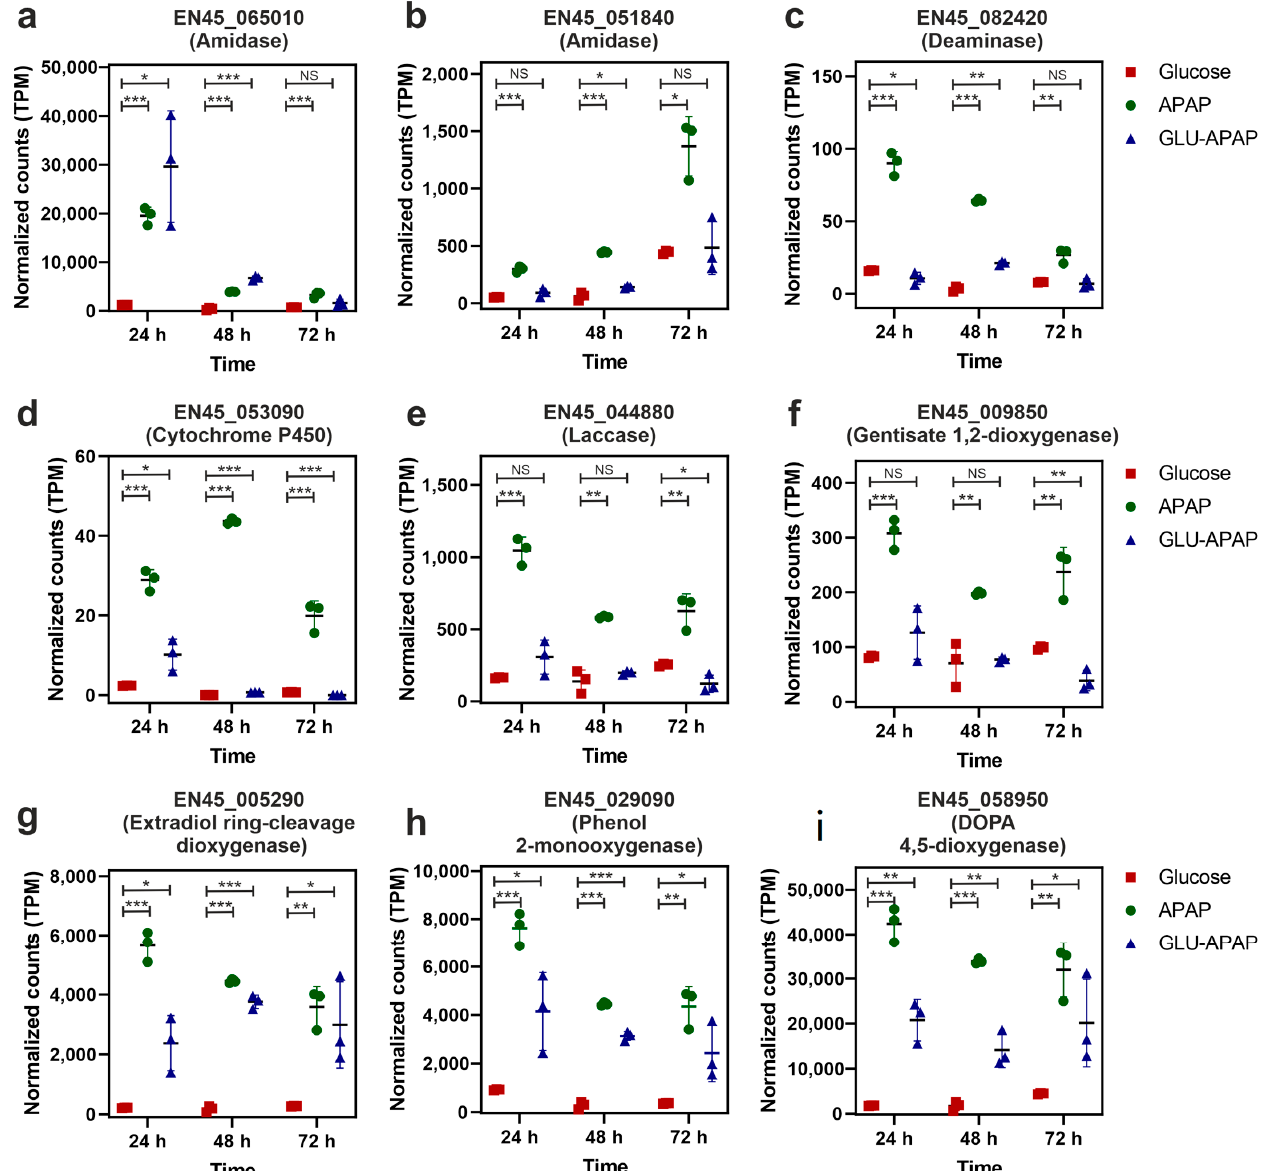
Figure 7. Normalized expression levels of selected gene transcripts encoding enzymes that are putative involved in the degradation of APAP by the strain of P. chrysogenum . Scattered dot plots represent the median value of expression and the standard deviation of the biological replicates. ( a )